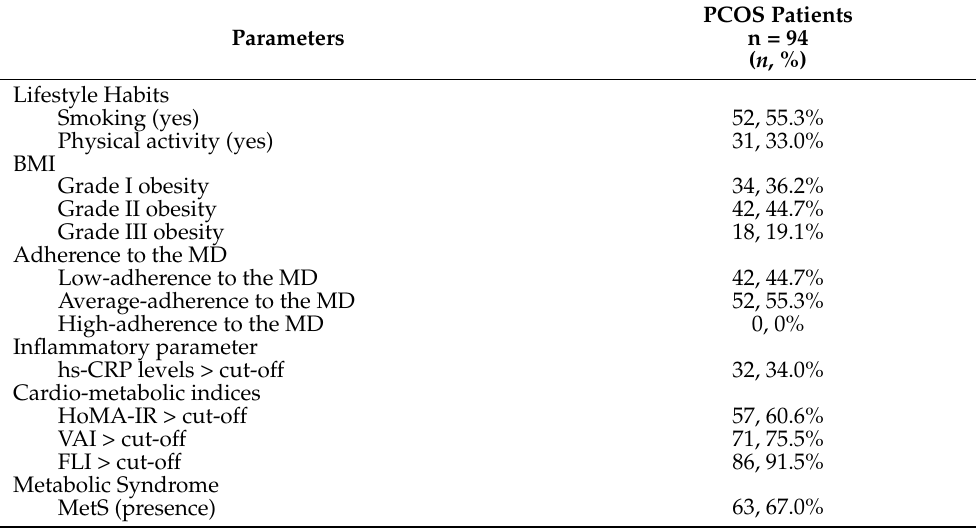
Table 2. Categorical variables analysed in this